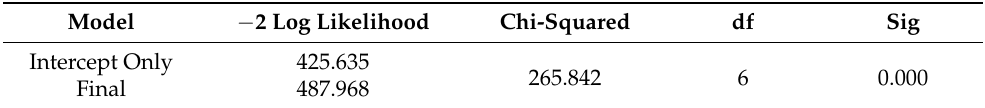
Table 6. Model fitting of ordinal